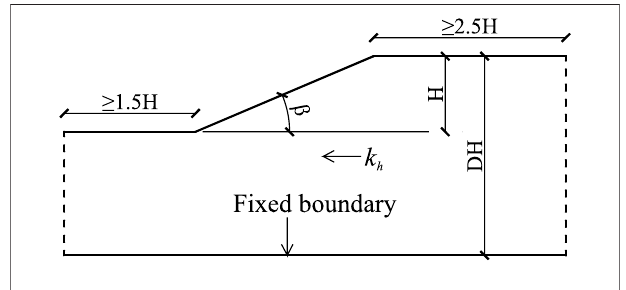
FIGURE 1 | Simple slope model.